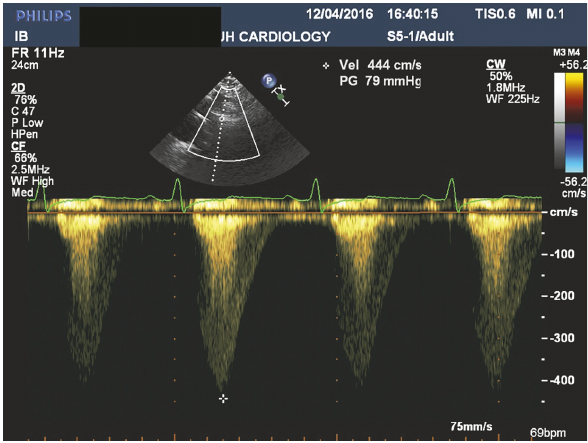
Figure 2: Suprasternal view of TTE with Doppler showing a peak gradient of 79 mmHg suggesting the presence of aortic